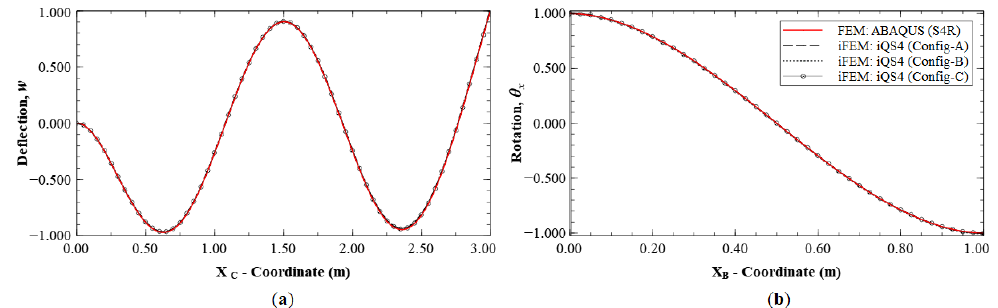
Figure 15. Reconstruction results for Mode 6; line plots of: ( a ) deflection w , along section C-C’; and ( b ) rotation 𝜃 𝑥 , along section B-B’; (see Figures 5b and 8b for the section definitions).